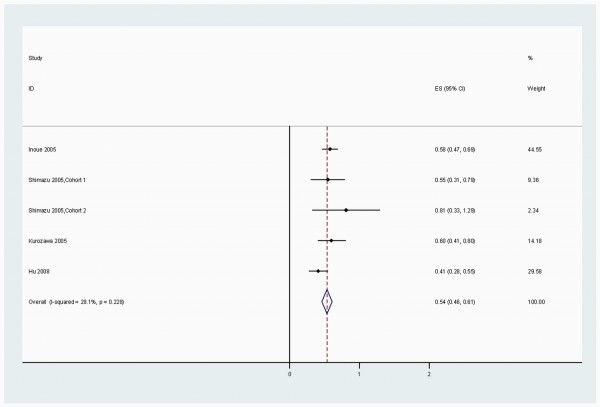
Summary RRs of hepatocellular cancer for high coffee drinkers versus non/lowest drinkers from included studies. Squares represent study-specific relative risk estimates (size of the square reflects the study-specific statistical weight, that is, the inverse of the variance); horizontal lines represent 95% CIs; diamonds represent summary relative risk estimates with corresponding 95% CIs.